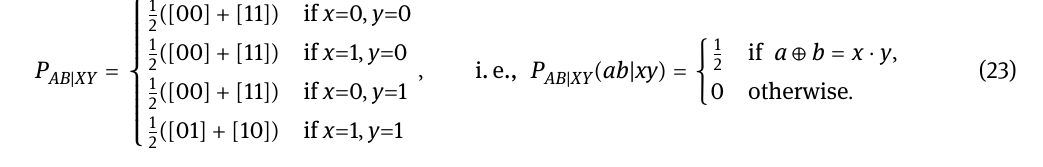
Figure 7: The Bell scenario causal structure. The local outcomes, A and B , of a pair of measure- ments are assumed to each be a function of some latent common cause and their independent local experimental settings, X and Y